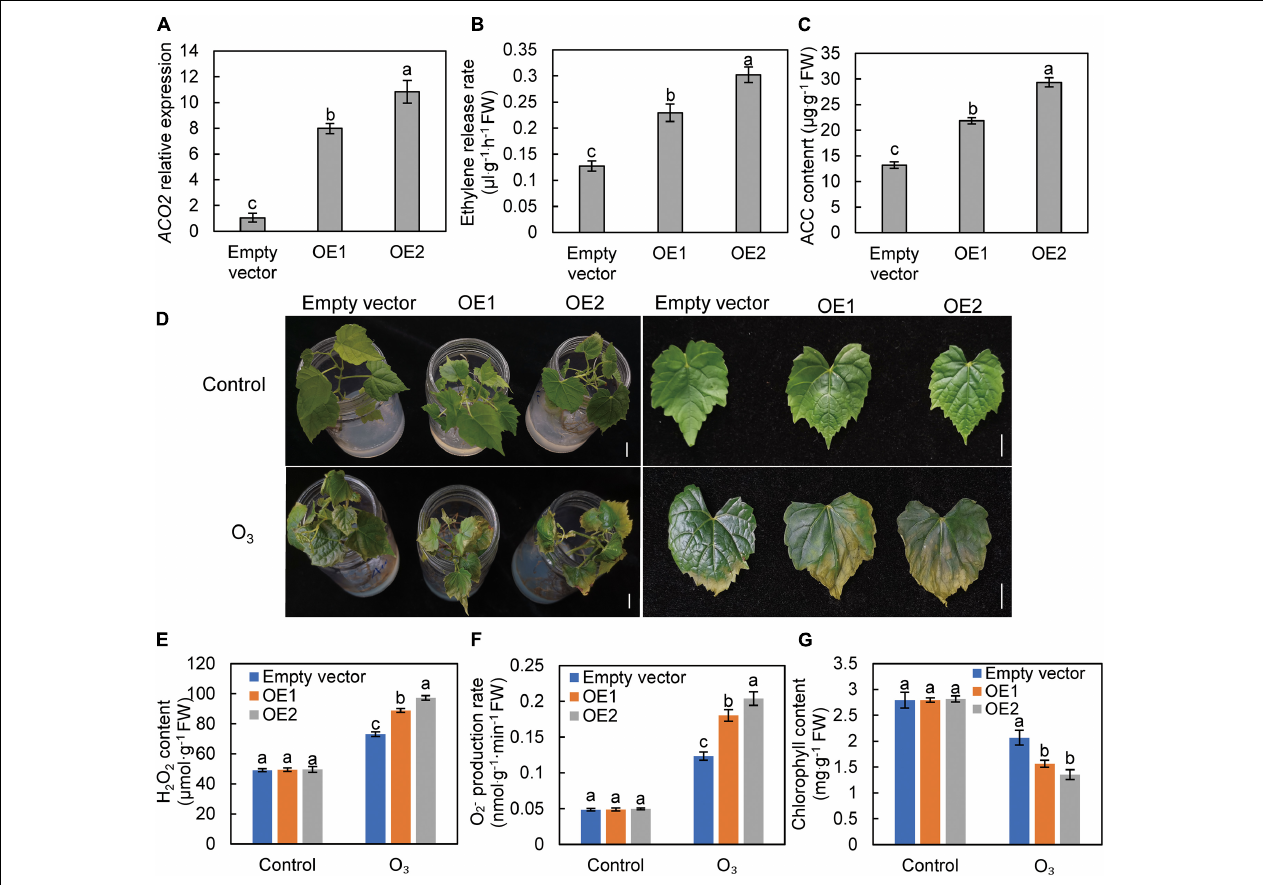
FIGURE 5 | The effect of VvACO2 overexpression on the response of grape leaves to O 3 stress. The ACO2 relative expression (A) , ethylene release rate (B) , and ACC content (C) in over-expressing (OE) and control (empty vector). The leaf appearance (D) , ROS (E,F) , and chlorophyll content (G) of the tissue culture seedlings of “Cabernet Sauvignon” grape after O 3 stress. Letters marked by the same lowercase letters are not significant at P < 0.05 (Duncan’s multiple range test). Bars, 1